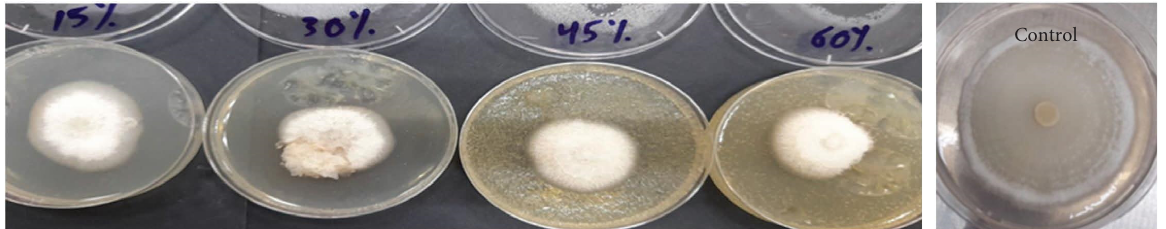
Figure 2: Efects of Paecilomyces sp . fltrate on the growth of R. solani as tested by the dual agar method on PDA at 25 ° C for 7 days. Table 1: Efects of the fltrate on Rhizoctonia solani growth. Concentration